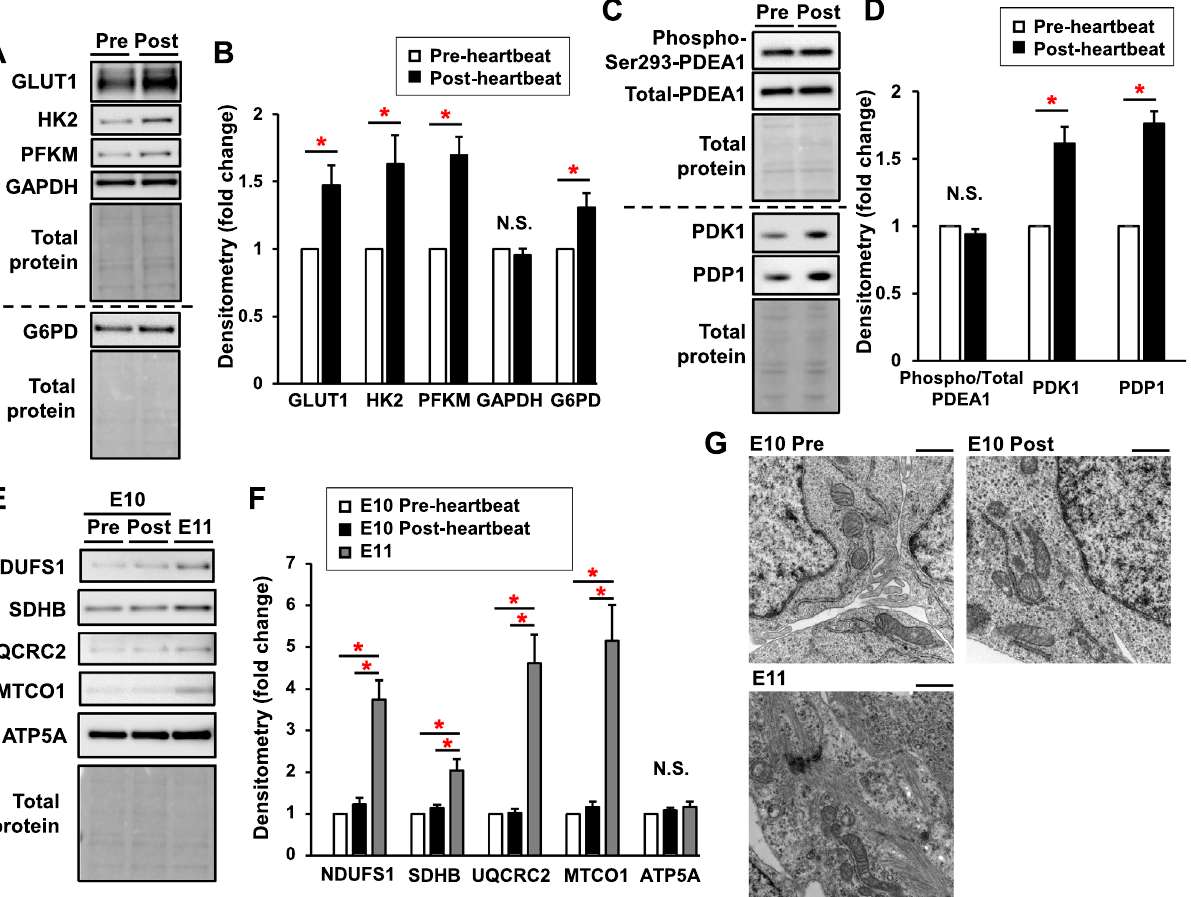
Figure 6. Increased protein expression of HIF-1α downstream targets without changes in mitochondrial respiratory complexes in the heart primordium after heartbeat initiation. ( A , B ) Representative images of Western blots ( A ) and densitometry ( C ) of GLUT1, HK2, PFKM, GAPDH, and G6PD in the pre- and post- heartbeat groups (N = 6). ( C , D ) Representative images of Western blots ( C ) and densitometry ( D ) of Ser 297 phospho-PDH E1α (PDEA1), total PDEA1, PDK1, and PDP1 in the pre- and the post-heartbeat groups (N = 6). ( E , F ) Representative images of Western blots ( E ) and densitometry ( F ) of NDUFS1, SDHB, UQCRC2, MTCO2, and ATP5A in the pre-heartbeat group, the post-heartbeat group, and the heart primordium at E11 (N = 6). ( G ) Representative transmission electron microscopy images of the heart primordium in the pre-heartbeat group, the post-heartbeat group, and the heart primordium at E11. Black scale bar indicates 1.0 μm. *p < 0.05 with Welch’s t-test for comparison of two groups and ANOVA with Tukey–Kramer’s post hoc test for comparison of three groups. N.S.: not significant. Full-length blots/gels are presented in Supplementary Figures Increased protein expression of HIF‑1α downstream targets without changes in mitochondrial respiratory complexes in the heart primordium after heartbeat initiation. We also assessed the expression of key enzymes regulated by the HIF-1 pathway in glycolysis, pentose phosphate pathway, and TCA cycles. Protein expression levels of transporter type 1 (GLUT1), hexokinase-2 (HK2), and 6-phosphofructoki- nase muscle type (PFKM), which have been reported to control glycolytic flux 29 , were significantly higher by 1.5 fold, 1.6 fold, and 1.7 fold, respectively, in the post-heartbeat group than in pre-heartbeat group, while expression levels of GAPDH were comparable in the two groups (Fig. 6A,B). The level of glucose-6-phosphate dehydroge- nase (G6PD), which plays a role as a rate-limiting step in the pentose phosphate pathway, was also significantly higher in the post-heartbeat group than in the pre-heartbeat group (Fig. 6A, B). Since HIF-1α is known to inhibit the TCA cycle via phosphorylation of PDH E1α subunit induced by activation of PDK1 21 , we assessed the levels of expression of PDK1 and phosphorylation of PDH E1α subunit (Fig. 6C,D). As expected, the expression level of PDK1 was significantly higher in the post-heartbeat group than in the pre-heartbeat group; however, phos- phorylation levels of PDH E1α subunit were comparable in the two groups (Fig. 6C,D). We also assessed expres- sion levels of pyruvate dehydrogenase phosphatase catalytic subunit 1 (PDP1) since PDP1 phosphatases PDH E1α to activate TCA cycles and its activity is known to be regulated by cellular calcium concentration 30 . The level of PDP1 was significantly increased in the post-heartbeat group compared with that in the pre-heartbeat group (Fig. 6C,D). These findings suggest that the activity of PDH E1α was not suppressed in the post-heartbeat group